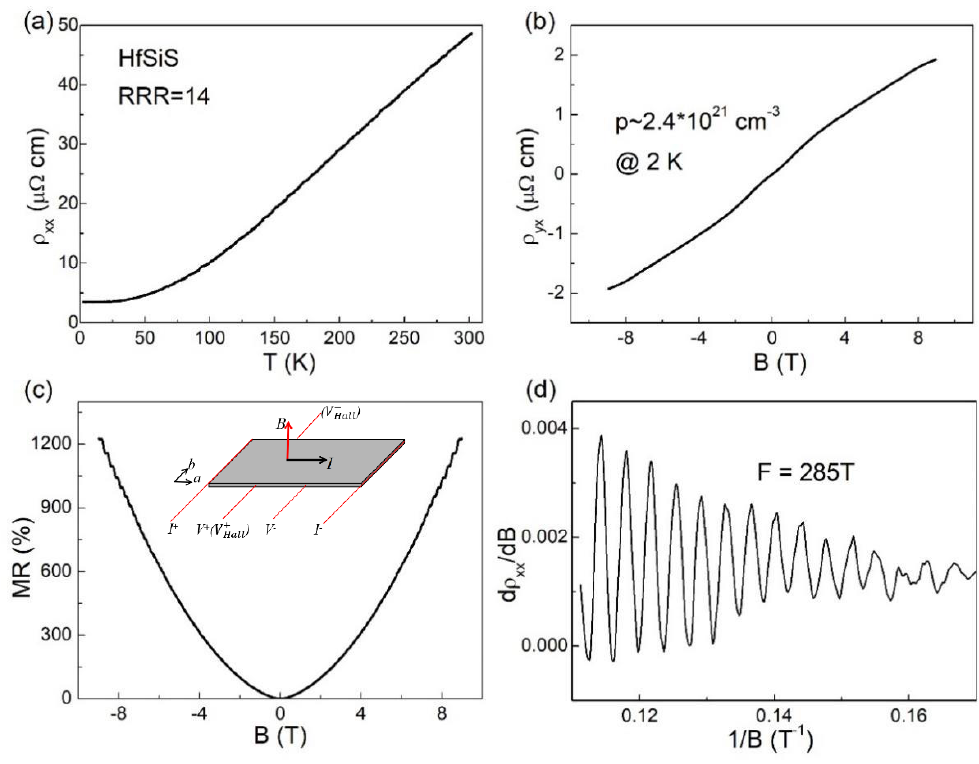
Figure 4. Electronic properties of HfSiS. ( a ) The temperature dependence of longitudinal resistivity ( ρ xx ). ( b , c ) The field dependence of Hall resistivity ( ρ yx ) and MR measured at 2 K, respectively. ( d ) d ρ yx /dB as a function of 1/B, showing a clear SdH oscillation. During measurements, the current is applied in the ab plane and the magnetic field is perpendicular to the ab plane, as shown in the inset of ( c ).